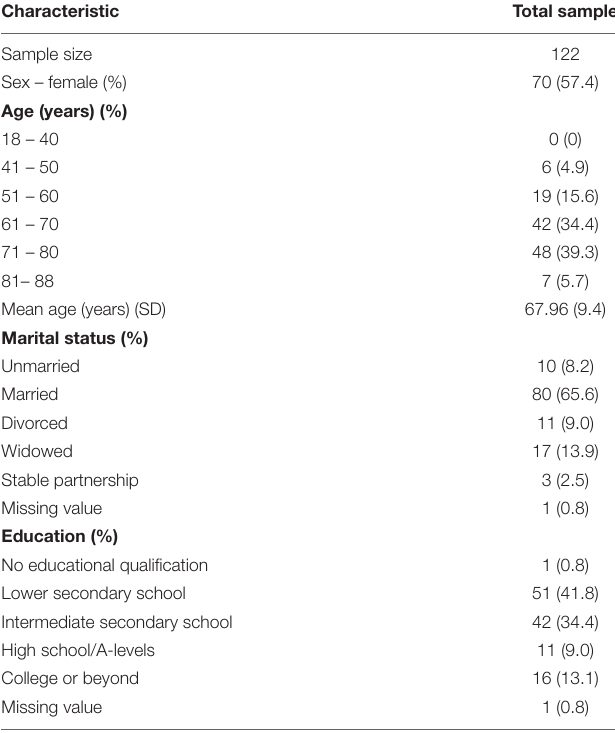
TABLE 1 | Basic information on